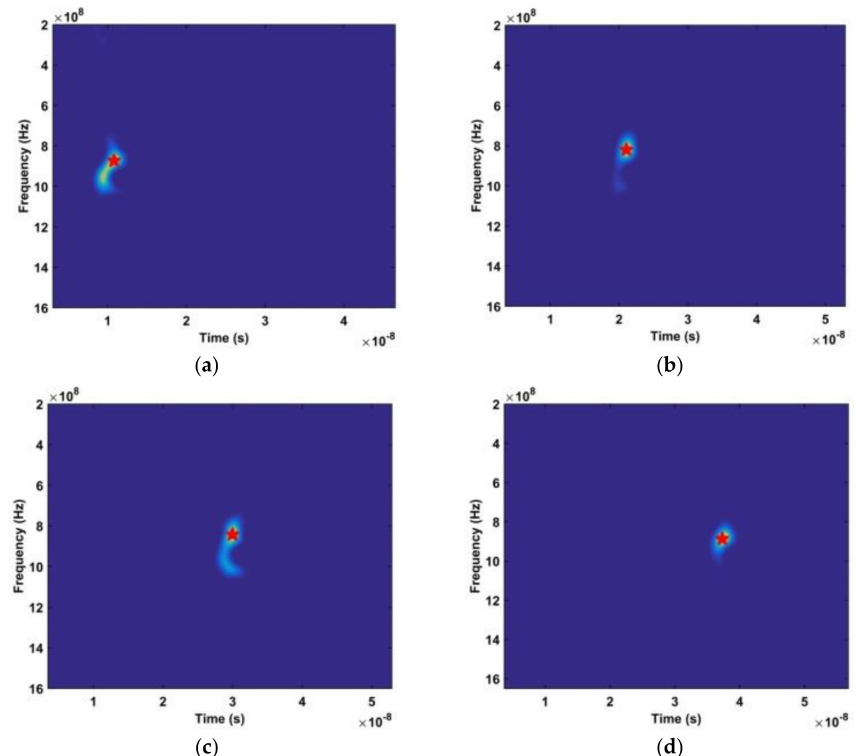
Figure 14. Results after performing the DWFT with a human subject at distances between the antenna and human subject of ( a ) 300 cm, ( b ) 600 cm, ( c ) 900 cm, and ( d ) 1100 cm.